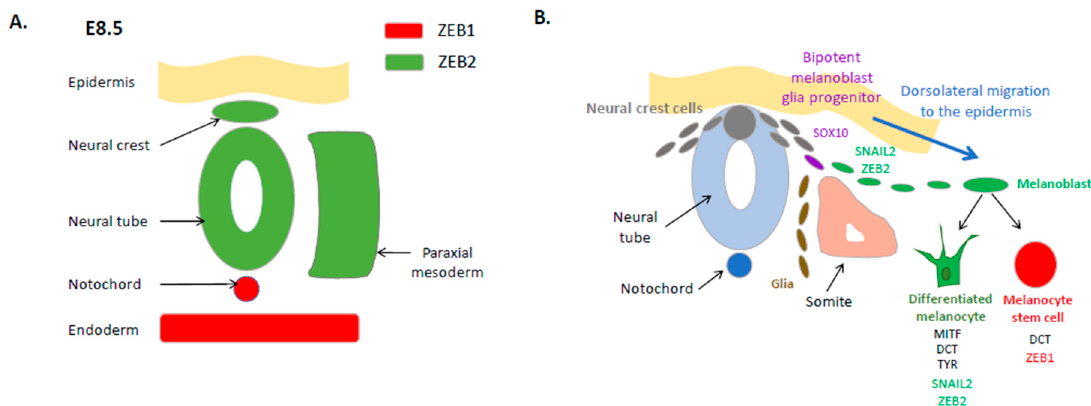
Figure 1. Expression and function of epithelial–mesenchymal transition transcription factors (EMT-TFs) in the embryonic neural crest and the melanocyte lineage. ( A ) Schematic representation of ZEB1 and ZEB2 opposite expression patterns in the mouse embryo at embryonic day E8.5. ( B ) Expression of EMT-TFs during the formation of the melanocyte lineage from the embryonic neural crest. The transcription factor SOX10 is expressed in a bipotent melanoblast/glial progenitor. SNAIL2 and ZEB2 are required for neural crest cell delamination and melanoblast specification and migration through a dorsolateral pathway. SNAIL2 and ZEB2 are also required for the homeostasis of differentiated melanocytes in the epidermis, through the positive regulation of MITF expression. ZEB1 in contrast is expressed in dedifferentiated melanocyte stem cells, which have lost MITF expression. MITF: microphthalmia-associated transcription factor. DCT: dopachrome tautomerase. TYR: tyrosinase.